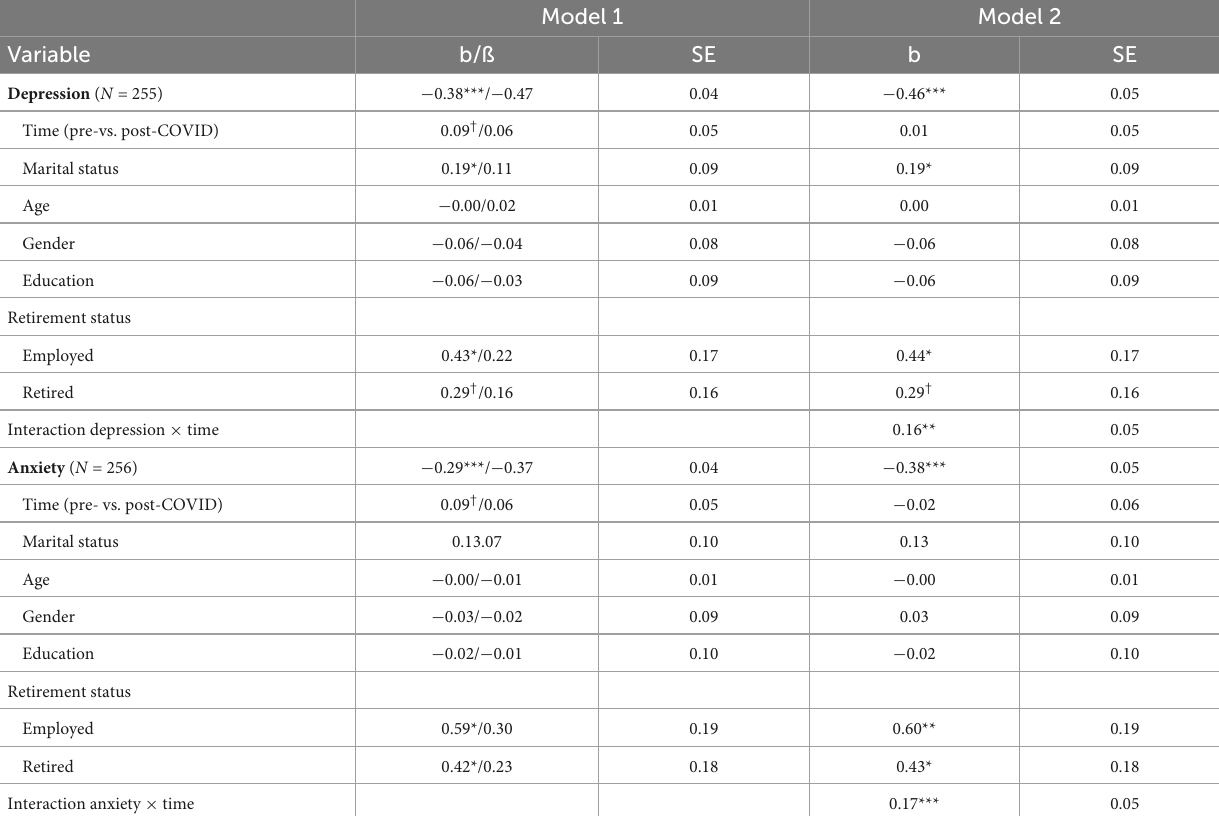
TABLE 6 Multilevel regression coefficients of depression and anxiety predicting happiness in older adults, study 2.